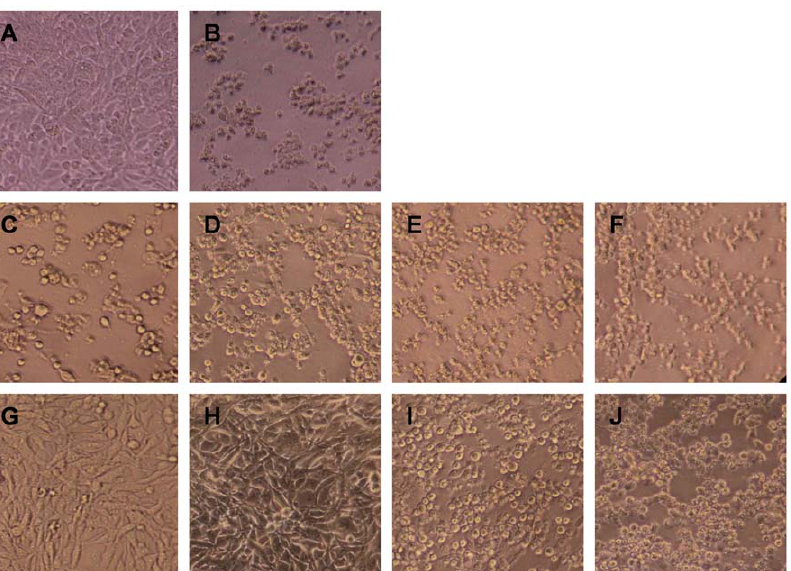
Figure 9. Postattachment neutralization by the anti-VLP sera. EV71 was allowed to attach to RD cells by incubation for 1 hour at 4 u C. The virus-attached cells were then treated for 1 hour at 37 u C with the antisera at different dilutions as indicated. Three days later, the treated cells were observed for CPE. (A) uninfected cells. (B) EV71-bound cells without antisera treatment. (C–F) EV71-bound cells were treated with the anti-Sf9 diluted 1:250, 1;500, 1:1000, and 1:2000, respectively. (G–J) EV71-bound cells were treated with the anti-VLP diluted 1:250, 1;500, 1:1000, and 1:2000, respectively.